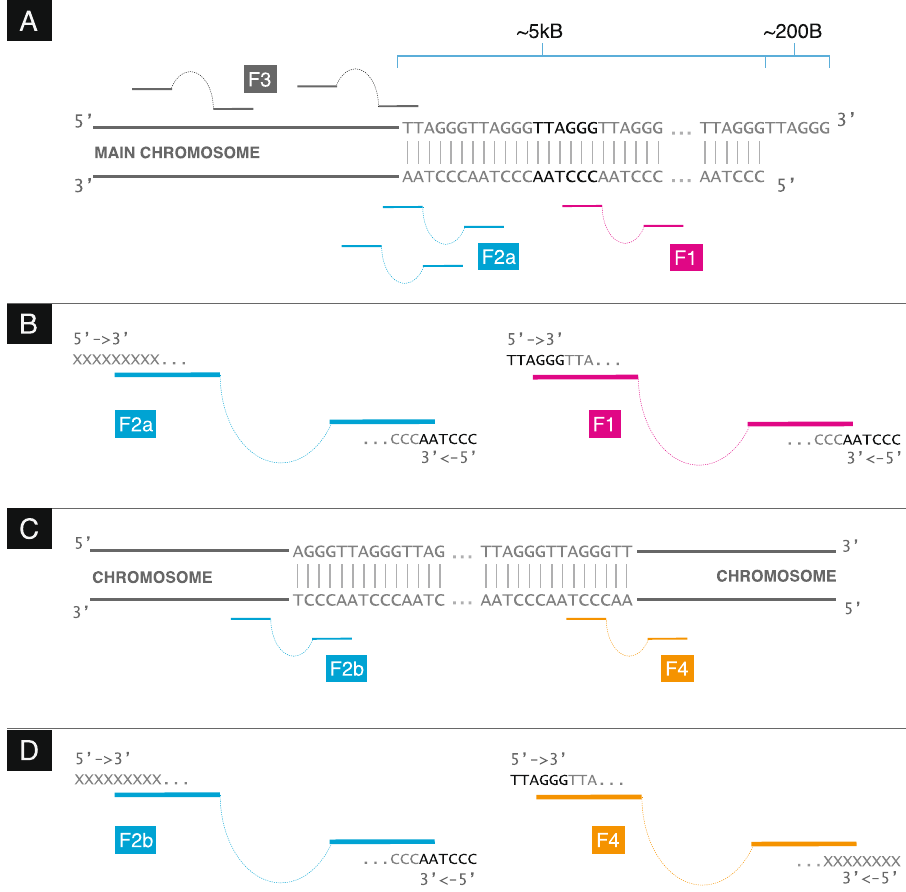
Figure 9. ( A ) The read-pair types at the boundary between telomere and subtelomere. F2a reads stem from the boundary whereas F1 reads stem from anywhere within the telomere proper. F3 are reads where neither read in the pair is complete telomere ( B ) Detail of the F1 and F2a read types. F1 read-pairs are comprised of two complete telomere reads. F2a read-pairs are comprised of a read-pair where one read is complete telomere and the other is not. Crucially, the complete telomere read is comprised of CCCTAA ( C ) The read-pair types at an ITR. ( D ) Detail of the F2b and F4 read types. Note that the F2b is physical indistinguishable from an F2a read. An F4 read is read-pair where one read is complete telomere and the other is not. The complete end is comprised of